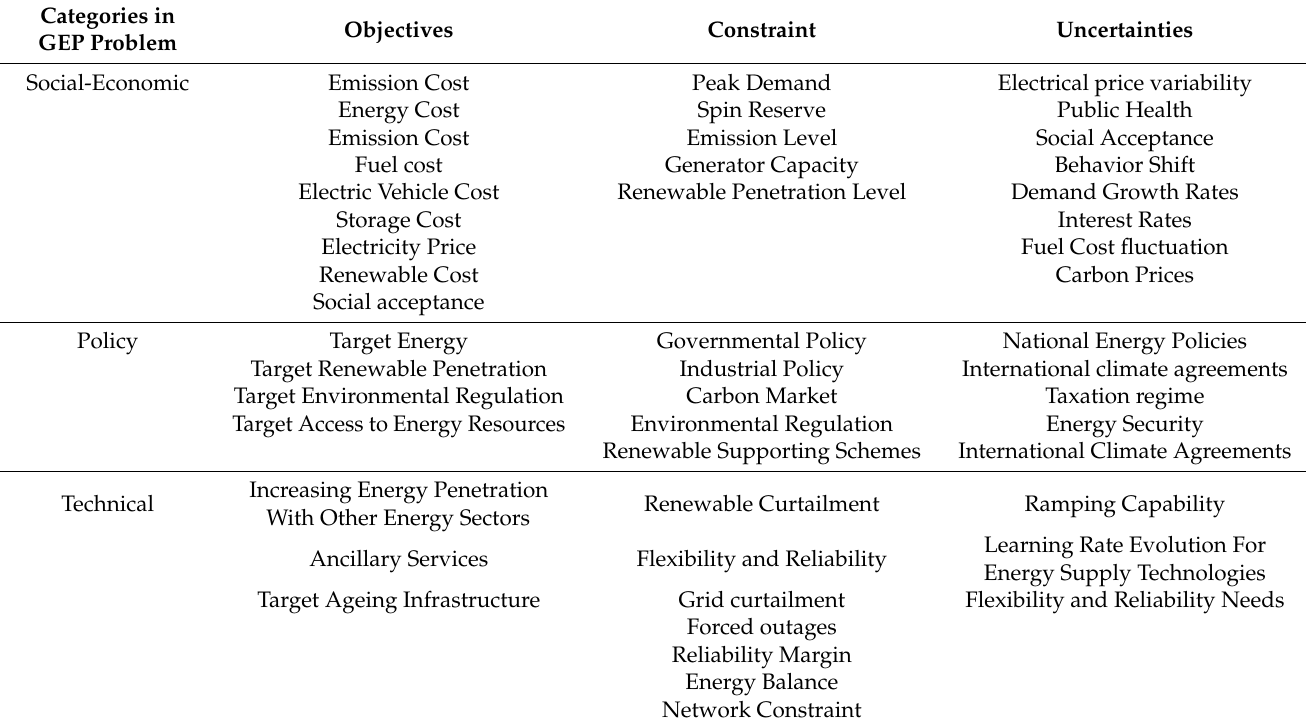
Table 5. Generic objective function, constraint, and uncertatnties in GEP [40–42]. Categories